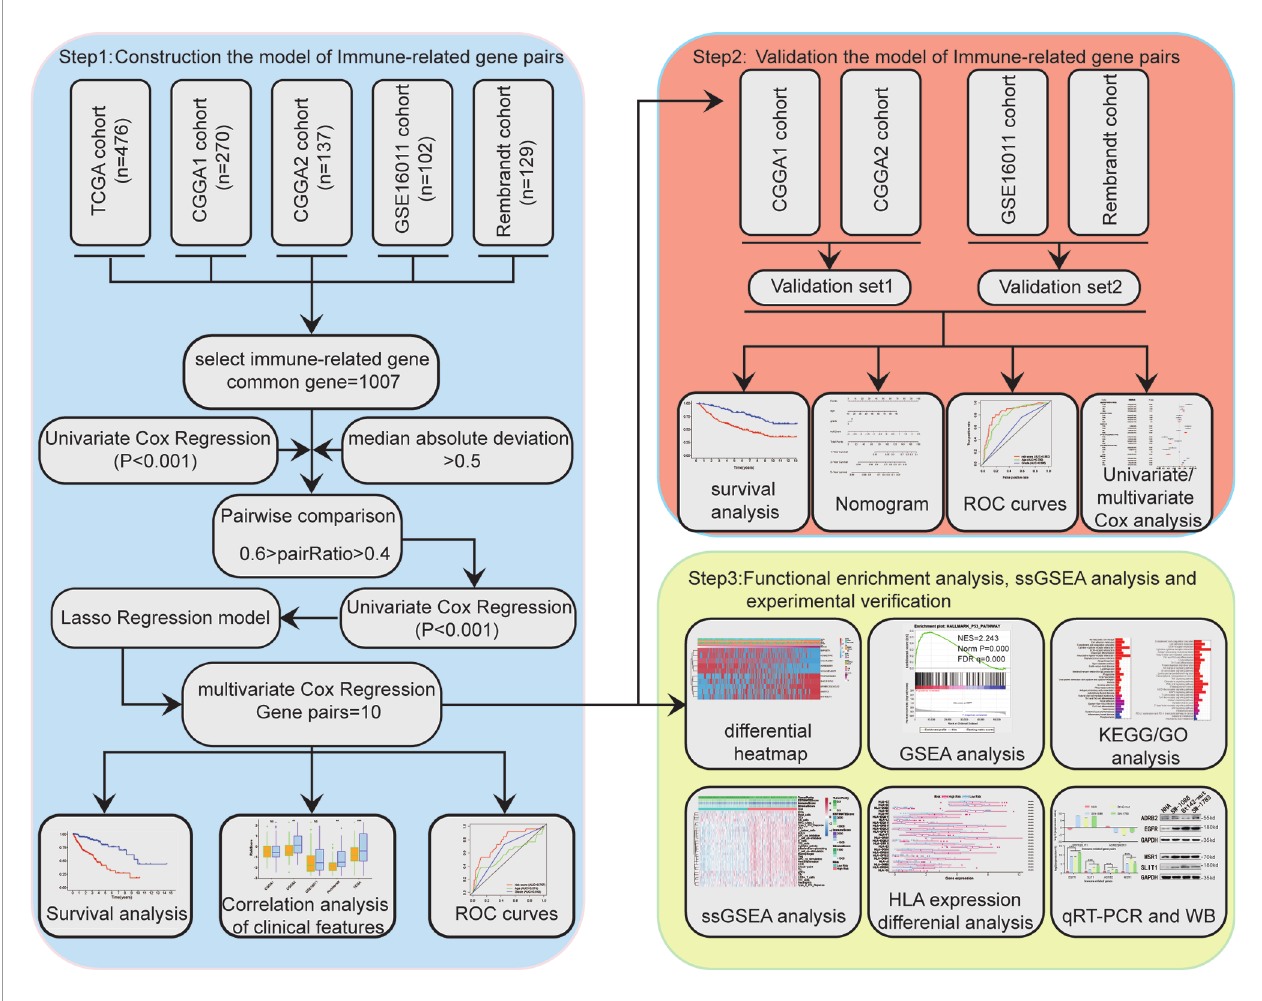
FIGURE 1 | Study fl ow